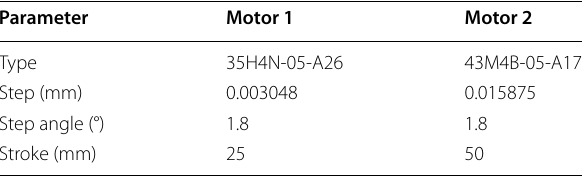
Table 2 Parameters of the linear stepper